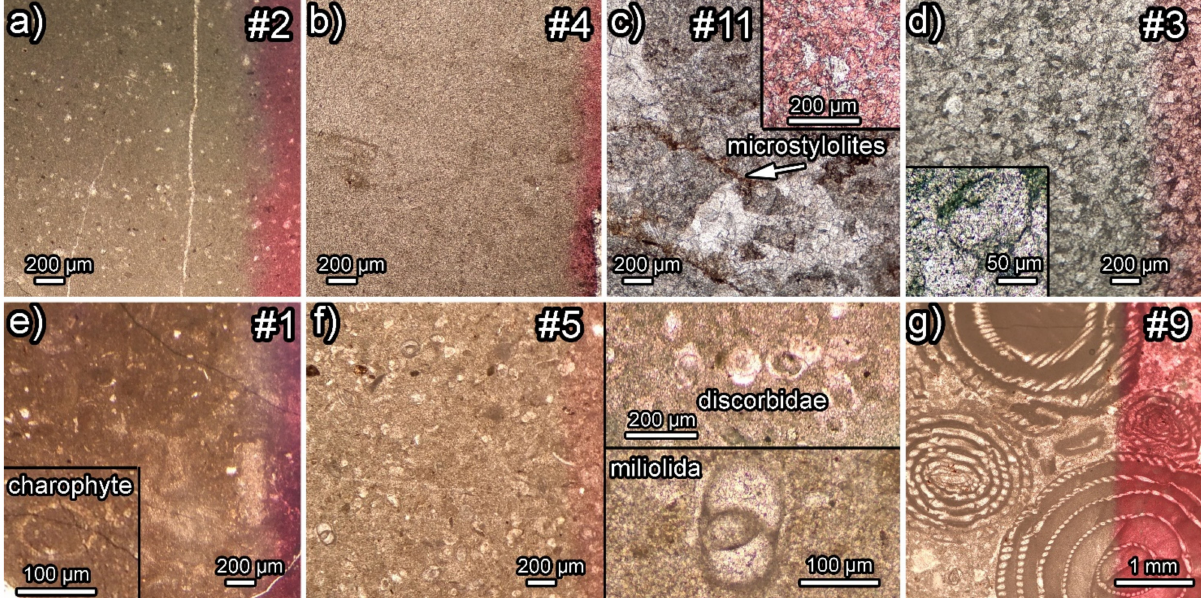
Figure 2. POM images of thin sections (PPL) of limestone tesserae from the Circus mosaic. The right red bands correspond to positive alizarin red S test: ( a ) #2 (pinkish gray) micritic limestone; ( b ) #4 (grayish brown) micritic limestone; ( c ) #11 (weak red) recrystallized micritic limestone with spar veins and microstylolites (inset, detail showing non stained dolomite); ( d ) #3 (white) sparite-rich limestone (inset, detail of calcite crystal); ( e ) #1 (dark gray) wackestone (inset, detail of algae fragment); ( f ) #5 (light yellowish brown) wackestone (on the right, detail of hyaline-tested ( top ) and porcelaneous-tested ( bottom ) foraminifera); ( g ) #9 (white dots in a pinkish background) Alveolina